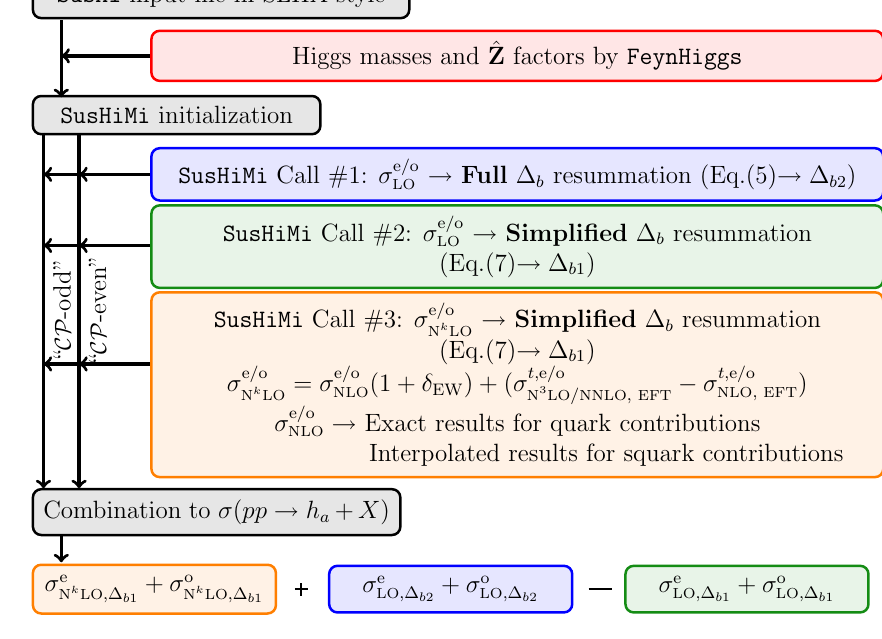
Fig. 2 Pictorial view of the gluon-fusion cross section